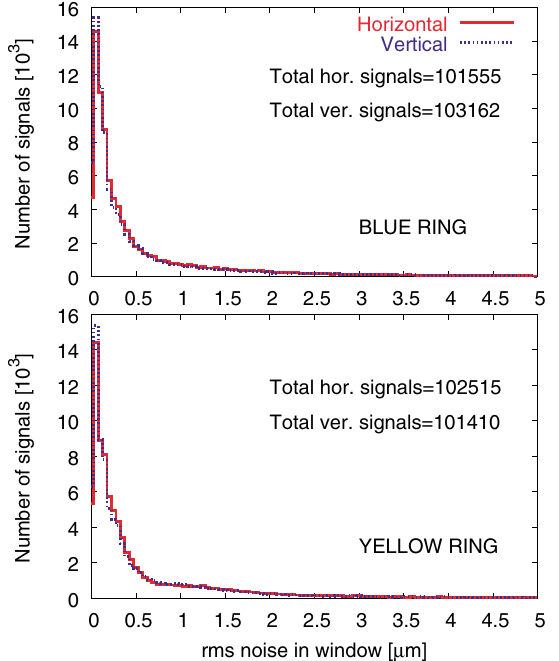
FIG. 8. (Color) Average rms observable versus longitudinal position of the BPM.